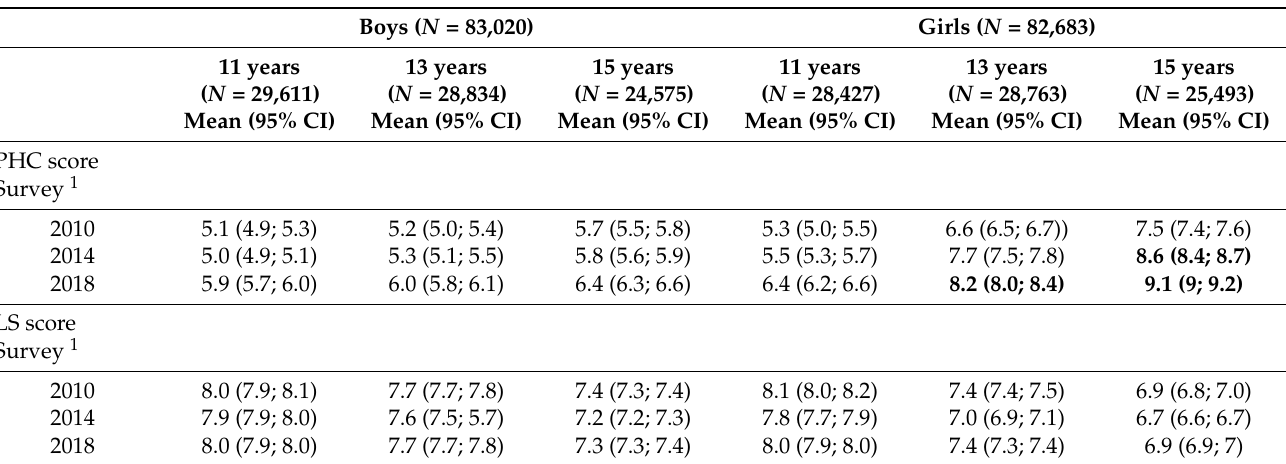
Table 1. PHC and LS across surveys, stratified by gender and age ( N = 165,683). PHC and LS as continuous variables.